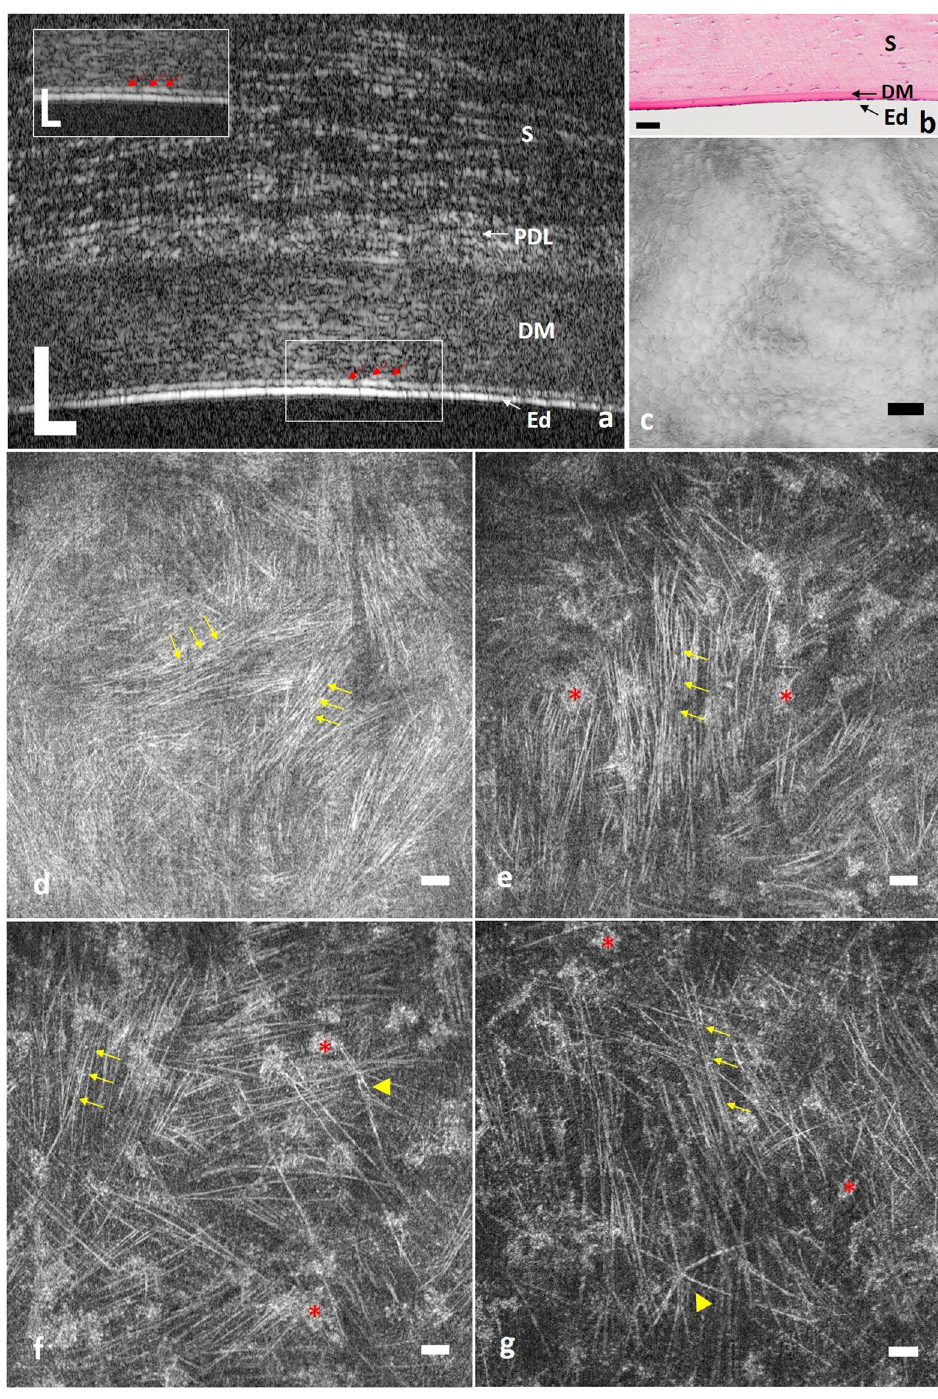
Figure 3. µ OCT imaging of pig cornea. ( a ) In vivo cross-sectional µ OCT image of swine posterior cornea. Inset is the zoomed-in view of the rectangular area; red arrows indicate endothelial cells. Corneal layers were clearly delineated, and collagen bundles in stroma were also visualized. ( b ) Cross-sectional histological image of posterior cornea. ( c ) Ex vivo en face view of the apical side of the endothelium presented regularly arranged polygonal cells. ( d – f ) Representative ex vivo en face views of posterior stroma from the lower to upper level. Both keratocytes (red asterisks) and collagen bundles (yellow arrows) were visualized, and the density of visible collagen bundles decreased from the most posterior to upper posterior stroma. Yellow triangles in ( f and g ) indicate nerve fibres in different patterns. S: stroma; PDL: pre-Descemet’s layer; DM: Descemet’s membrane; Ed: endothelium (Scale bar = 50 µ m and scale bar of inset in ( a ) is 25 µ